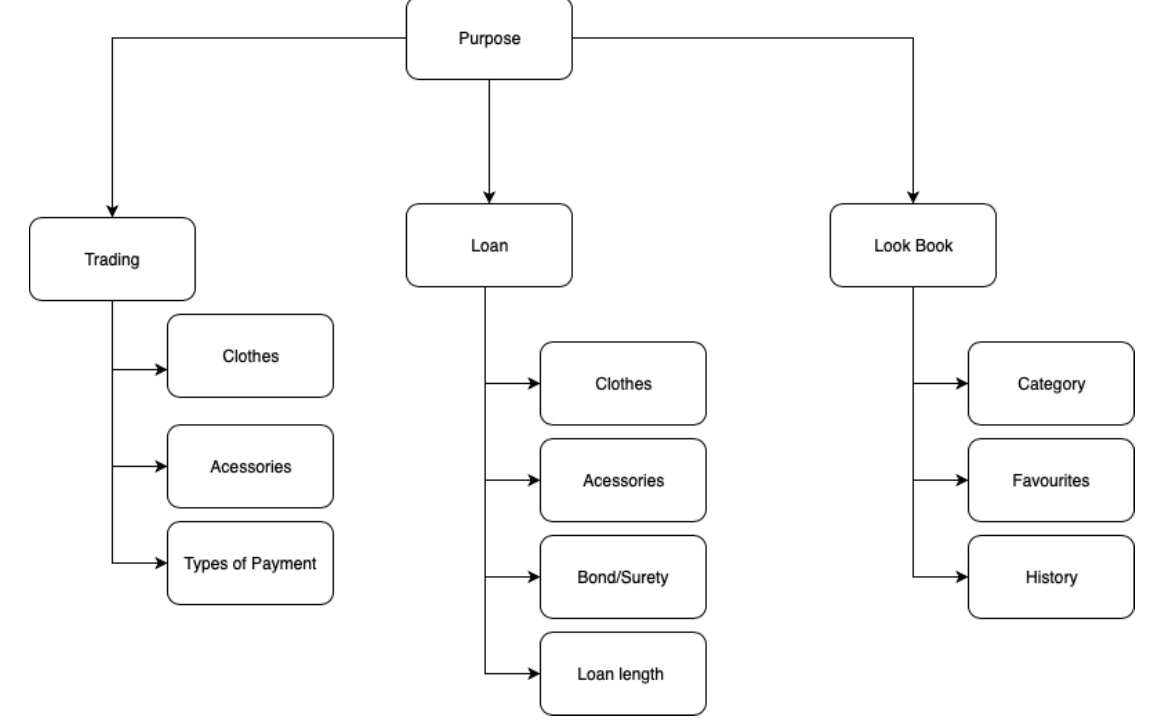
Figure 5. Taxonomy for the Mobile Applications and Web Platforms Analysed. Table 3. Distribution of Mobile Application by Categories of